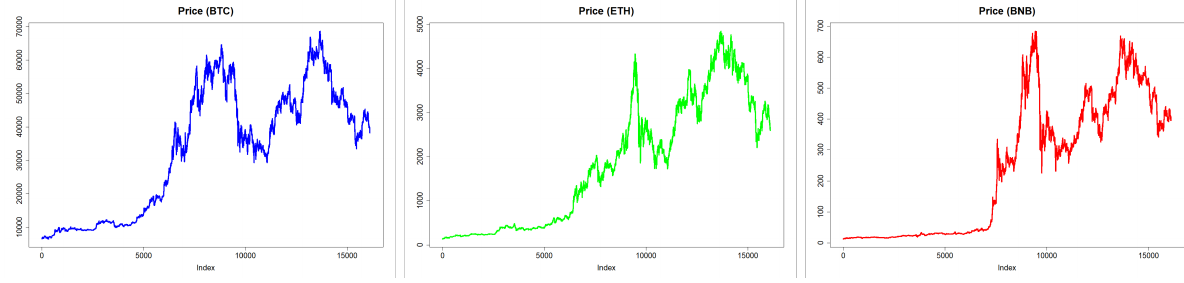
Figure 2. Hourly adjusted closing prices of cryptocurrencies (Group